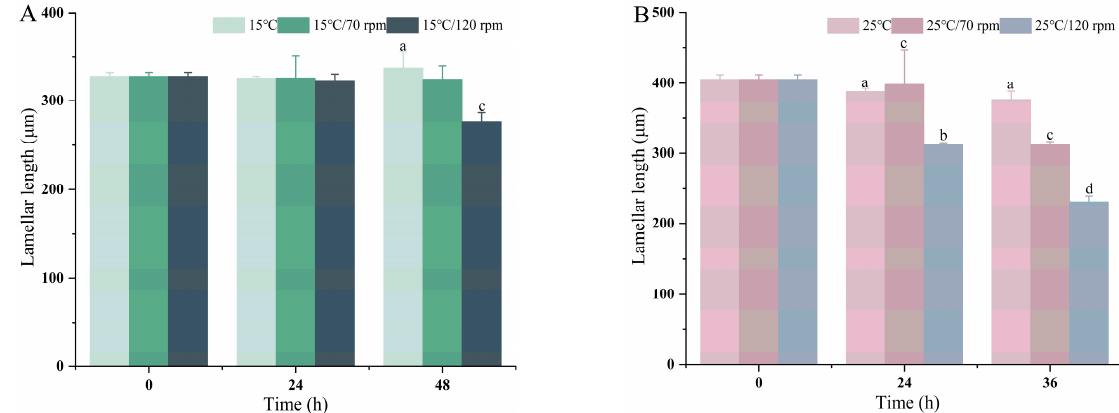
Figure 6. Quantification of fish gill structure. Length of gill lamellae of groupers at 15 ( A ) and 25 ◦ C ( B ). Values were obtained from average of all samples and given as means ± SD (n = 5). Different letters above the bars indicate significant differences among the treatments.